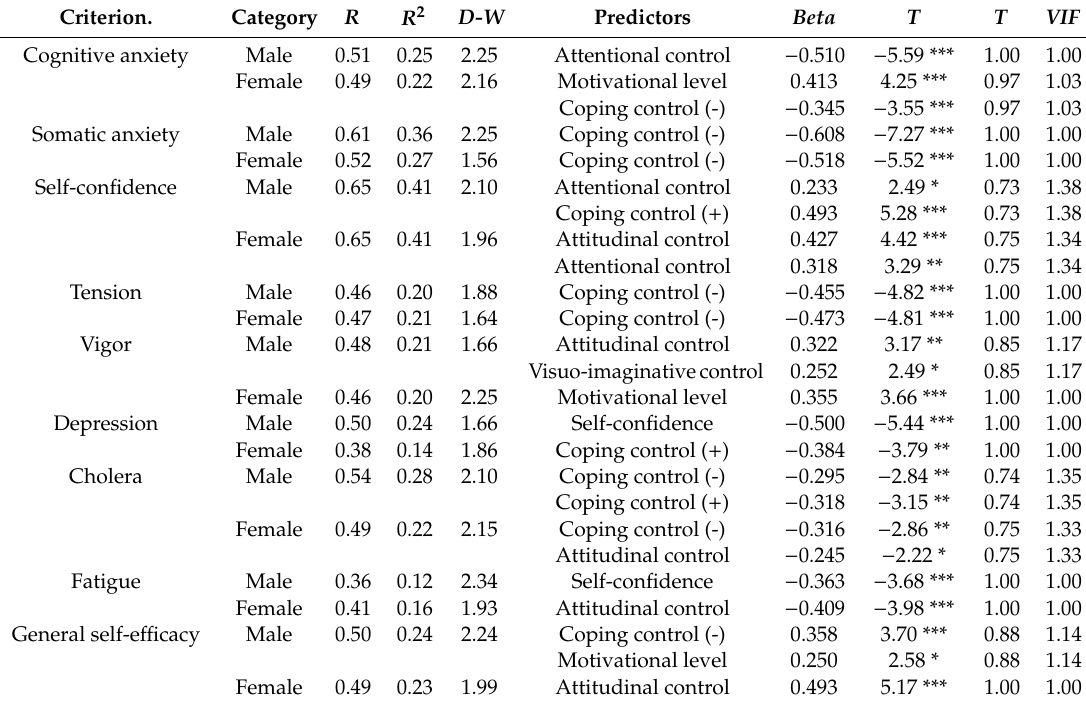
Table 5. Linear regression analysis (successive steps) by